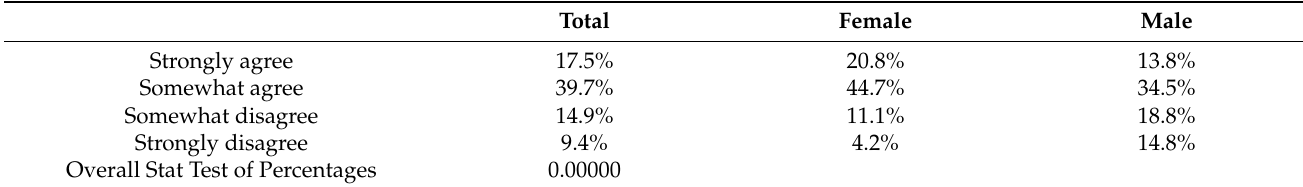
Table 3. The price of milk and other dairy products is fair in Canada.